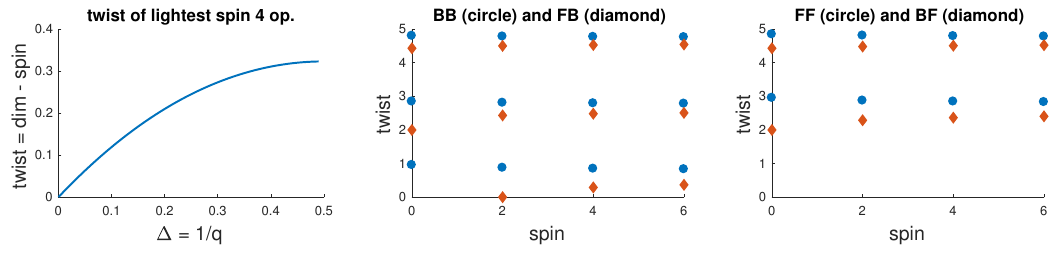
Figure 8 . At left we plot the twist of the lowest-twist spin four operator, as a function of (cid:1) = 1 This operator is in the FB channel. In the middle and right, we show the twists of several low-lying bosonic operators in di(cid:11)erent channels for the b q = 3 theory. For the FF channel, these are the top component, and for the BB channel these are the